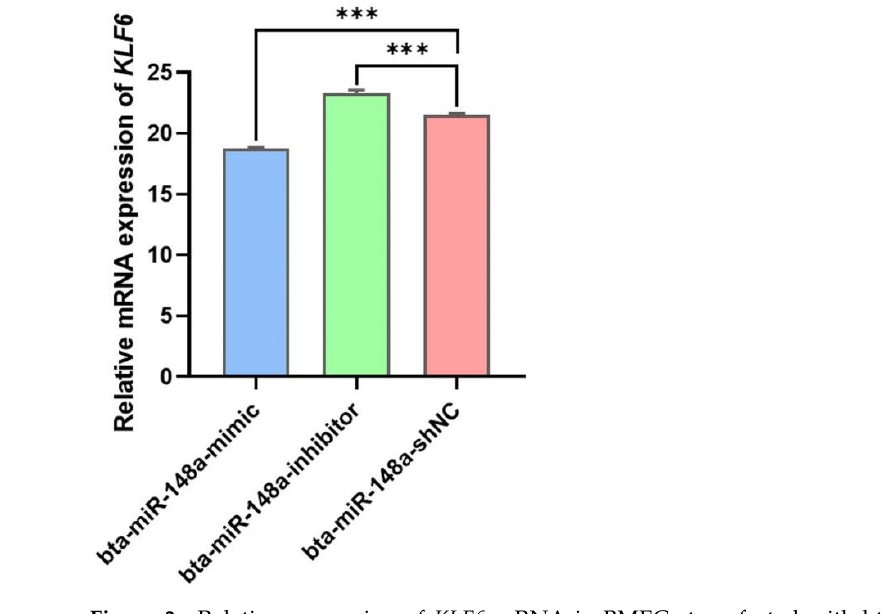
Figure 3. Relative expression of KLF6 mRNA in BMECs transfected with bta-miR-148a-mimic, bta-miR-148a-inhibitor, and bta-miR-148a-shNC. *** p <